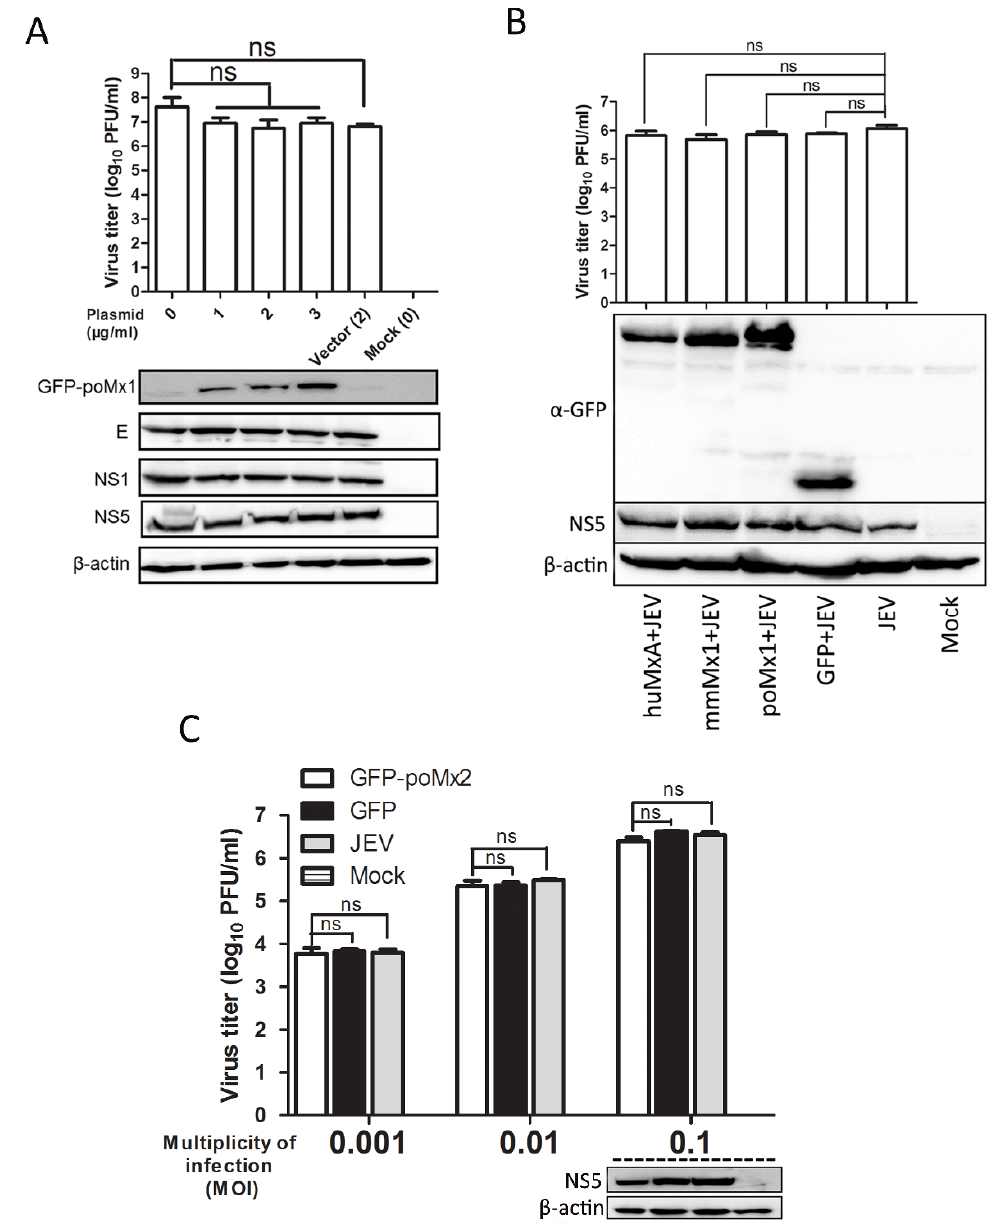
Figure 2. Exogenous Mx proteins fused to green fluorescent protein (GFP) have no anti-JEV activity. Three separate experiments were performed to assess the anti-JEV activity of the fused Mx1 and Mx2 protein. Cells were transfected with the constructs and then infected with JEV. At 24 hpi, lysates of the harvested cell culture were used to determine viral protein levels by Western blot analysis, the cell supernatants were used to determine the levels of infectious virus by plaque assay. ( A ) Cells transfected with the various concentrations of pEGFP-poMx1 and then infected with JEV at an MOI of 0.05; ( B ) Cells transfected with pEGFP-huMxA (human MxA), pEGFP-mmMx1, pEGFP-poMx1 (porcine Mx1), or pEGFP-C1 then infected with JEV at an MOI of 0.05; ( C ) Cells transfected with pEGFP-poMx2 or pEGFP-C1 and then infected with JEV at an MOI of 0.001, 0.01, and 0.1. All data are presented as means ± standard deviation (S.D.) as indicated. Statistical significance is indicated as ns ( p > 0.05).